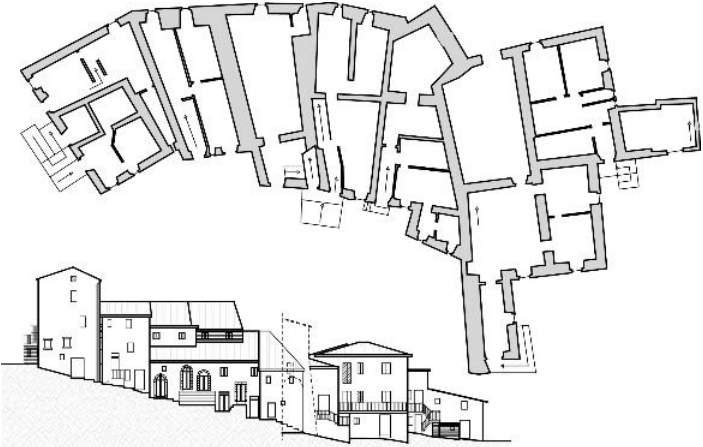
Figure 1. Example of a map and elevation of a complex civil building in a historic centre [3].